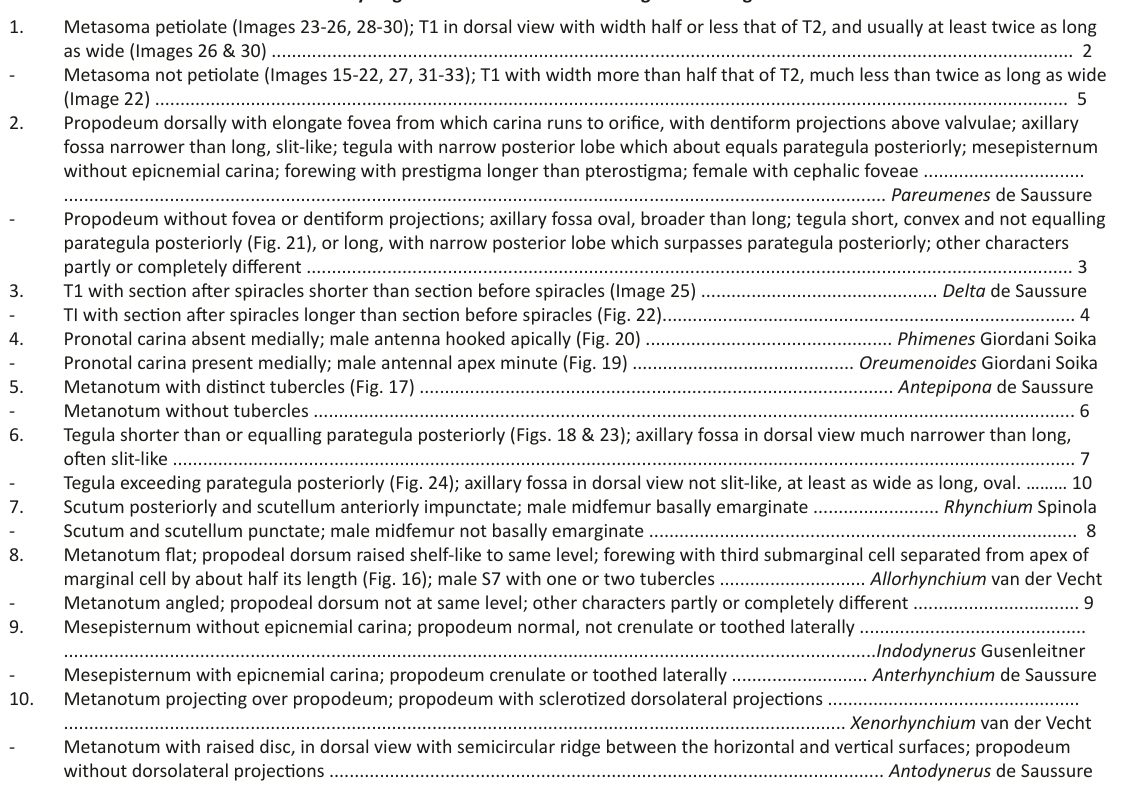
Mesepisternum with epicnemial carina; propodeum crenulate or toothed laterally ........................... Anterhynchium de Saussure 10. Metanotum projecting over propodeum; propodeum with sclerotized dorsolateral projections .................................................. ........................................................................................................................................................... Xenorhynchium van der Vecht Metanotum with raised disc, in dorsal view with semicircular ridge between the horizontal and vertical surfaces; propodeum without dorsolateral projections .............................................................................................................. Antodynerus de